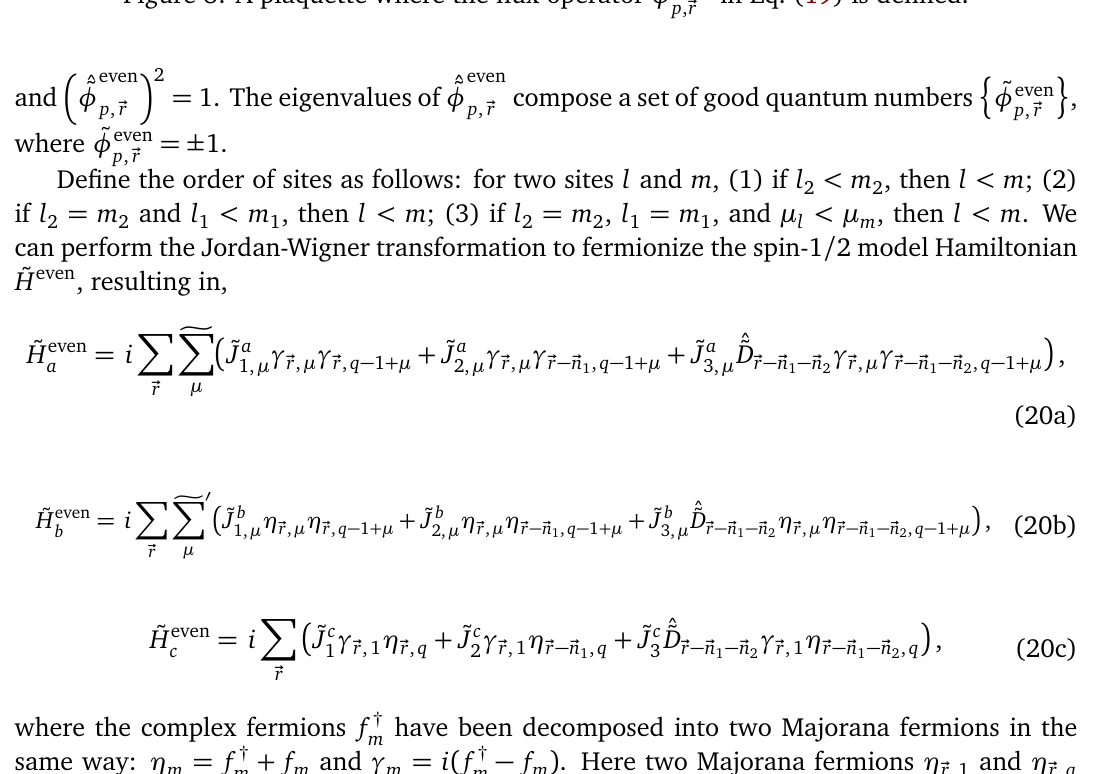
Figure 8: A plaquette where the flux operator